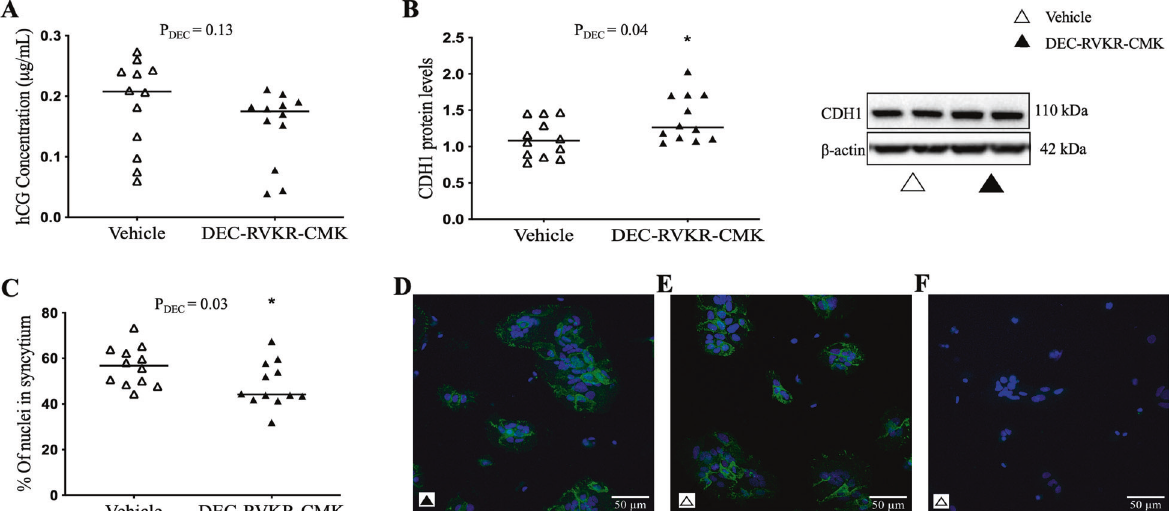
Fig. 2 DEC-RVKR-CMK did not affect syncytialisation of term human primary trophoblast cells. Trophoblast cells were treated with 50 μ M of the protease inhibitor DEC-RVKR-CMK and left to syncytialise for 48 h. DEC-RVKR-CMK had no effect on ( A ) hCG secretion, signi fi cantly increased ( B ) CDH1 protein levels, but did not affect ( C ) the percent of nuclei in syncytia. Representative images in ( D , E ) depict cells stained for CDH1 (green) and counterstained with DAPI (blue). F Is a negative control image omitting the primary antibody, controlling for